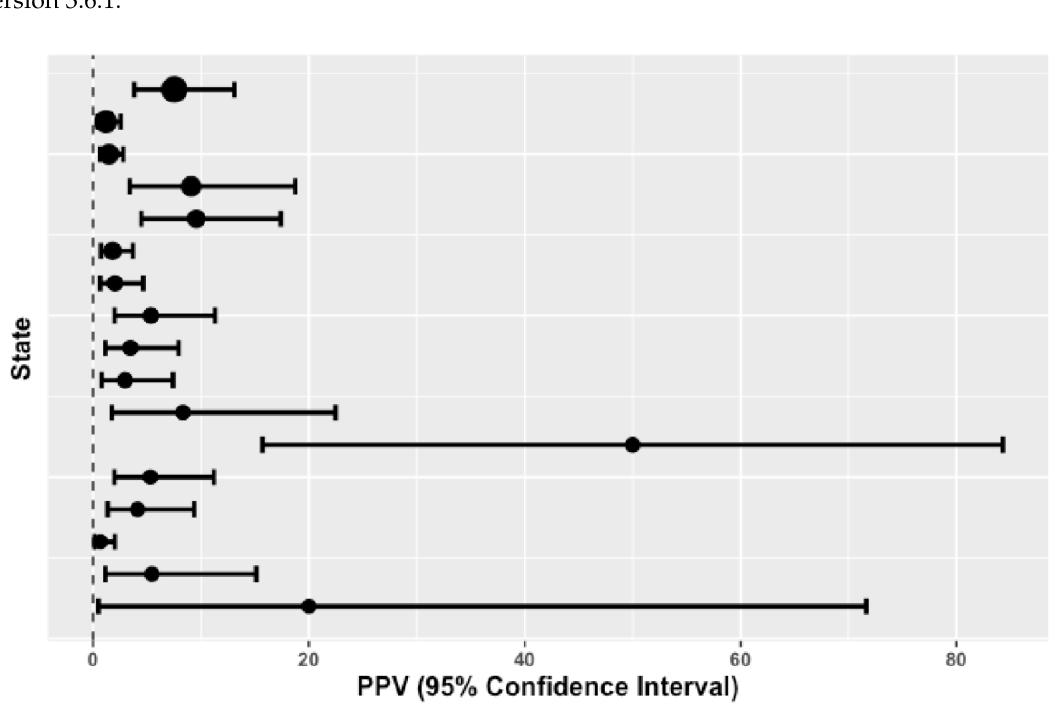
Figure 1. The positive predictive values (PPVs) calculated for each state are shown, with their respective 95% confidence intervals. States are ordered from the smallest to largest number of screens performed (from bottom up on y axis). Dot size is related to the number of screens performed (numerical data used are shown in Table 1).